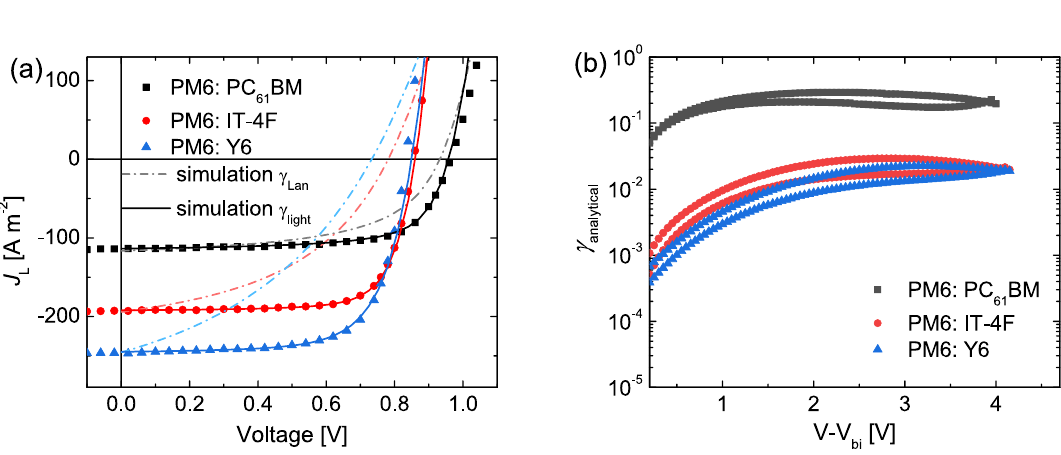
Figure 1.. ( a ) Current density–voltage characteristics of solar cells comprising a PM6 donor and PC 61 BM, IT-4F, or Y6 as the acceptor. The symbols represent experimental characteristics, the solid lines are fits of the data by drift diffusion simulations, with the experimental charge-carrier mobilities as input. With the mobilities known, the recombination rate determines the fill factor, where the results for Langevin recombination ( γ = 1) are represented by the dash-dotted lines. ( b ) Langevin prefactors directly obtained by Eq. (2) from the measured electron, hole, and double-carrier currents in